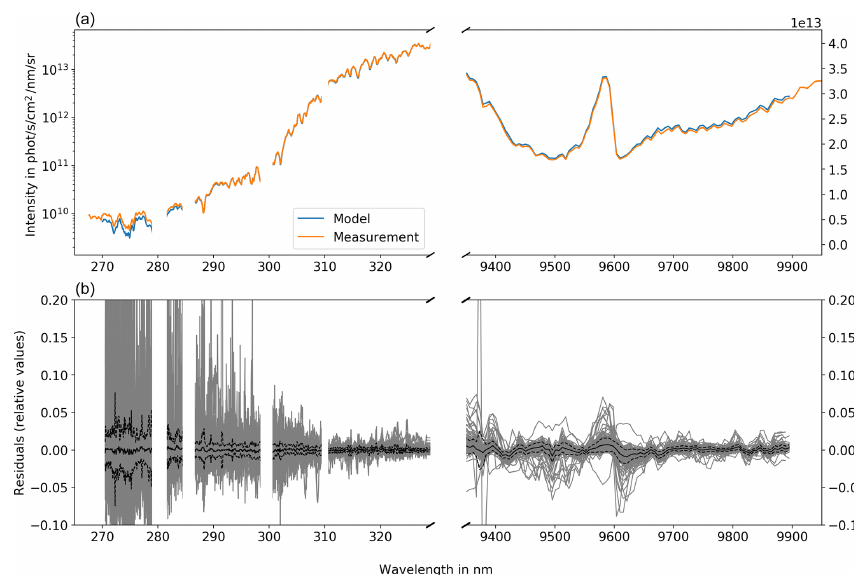
Figure 1. (a) Measured intensity from TROPOMI (270–329nm) and CrIS (9350–9900nm) on 6 July 2018 at 12:11LT (TROPOMI) com- pared to the modelled intensity after the iterative process. (b) Residuals from logarithmic fits for 242 ozone profile retrievals where collocated ozonesonde measurements are available. The residuals of individual retrievals are plotted in grey, while the mean of all residual spectra (solid line) and its standard deviation (dashed line) are given in